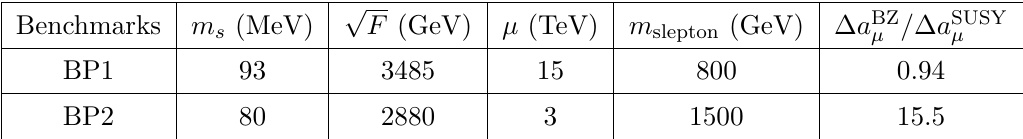
p F = 0 : 2, = m ~ (cid:22) = m ~ (cid:23) . The benchmark with L R